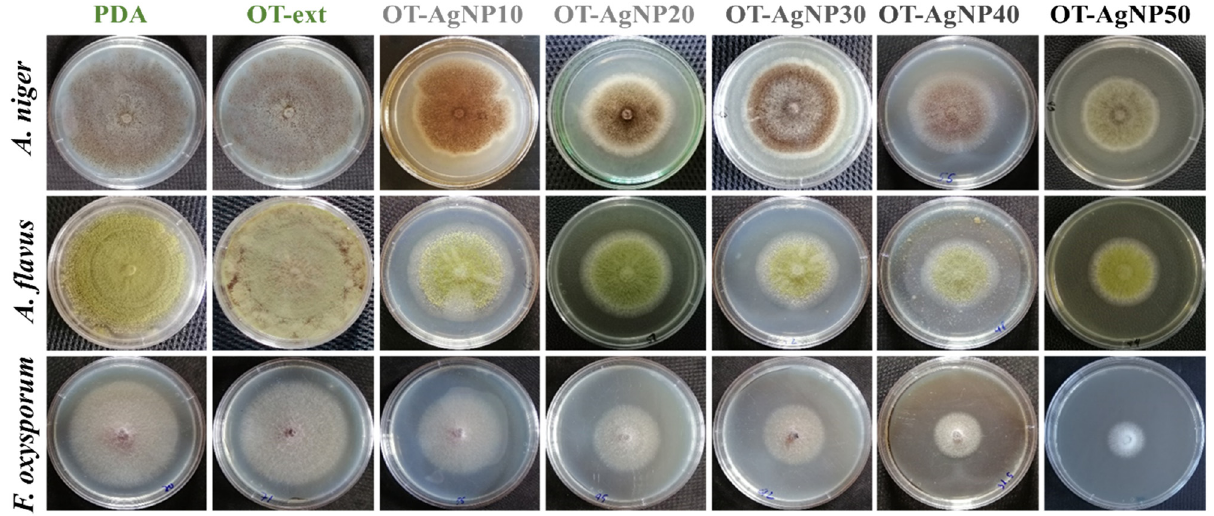
Figure 6: Growth zone of A. niger , A. fl avus , and F. oxysporum in di ff erent media including pure PDA, PDA mixed with OT - ext ( abbreviated as OT - ext ) , and PDA mixed with 10, 20, 30, 40, and 50 ppm of OT - AgNPs ( abbreviated as OT - AgNP10, OT - AgNP20, OT - AgNP30, OT - AgNP40, and OT - AgNP50, respectively ) after 96